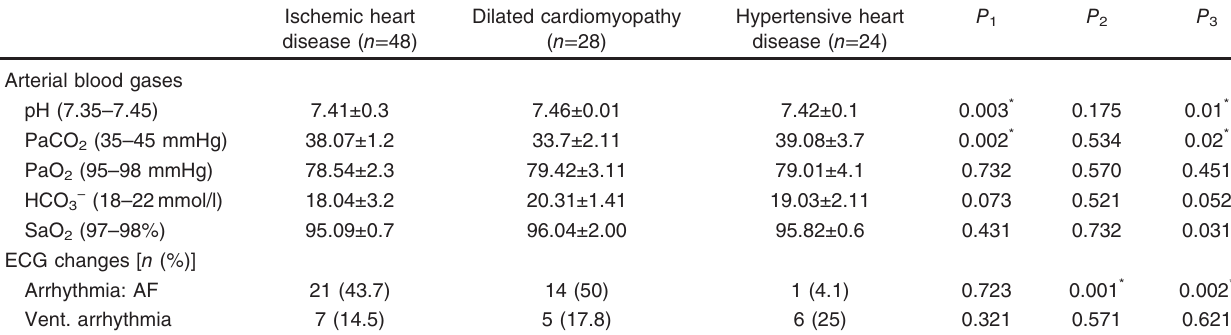
Table 2 Gasometeric parameter and ECG changes between different groups of heart failure